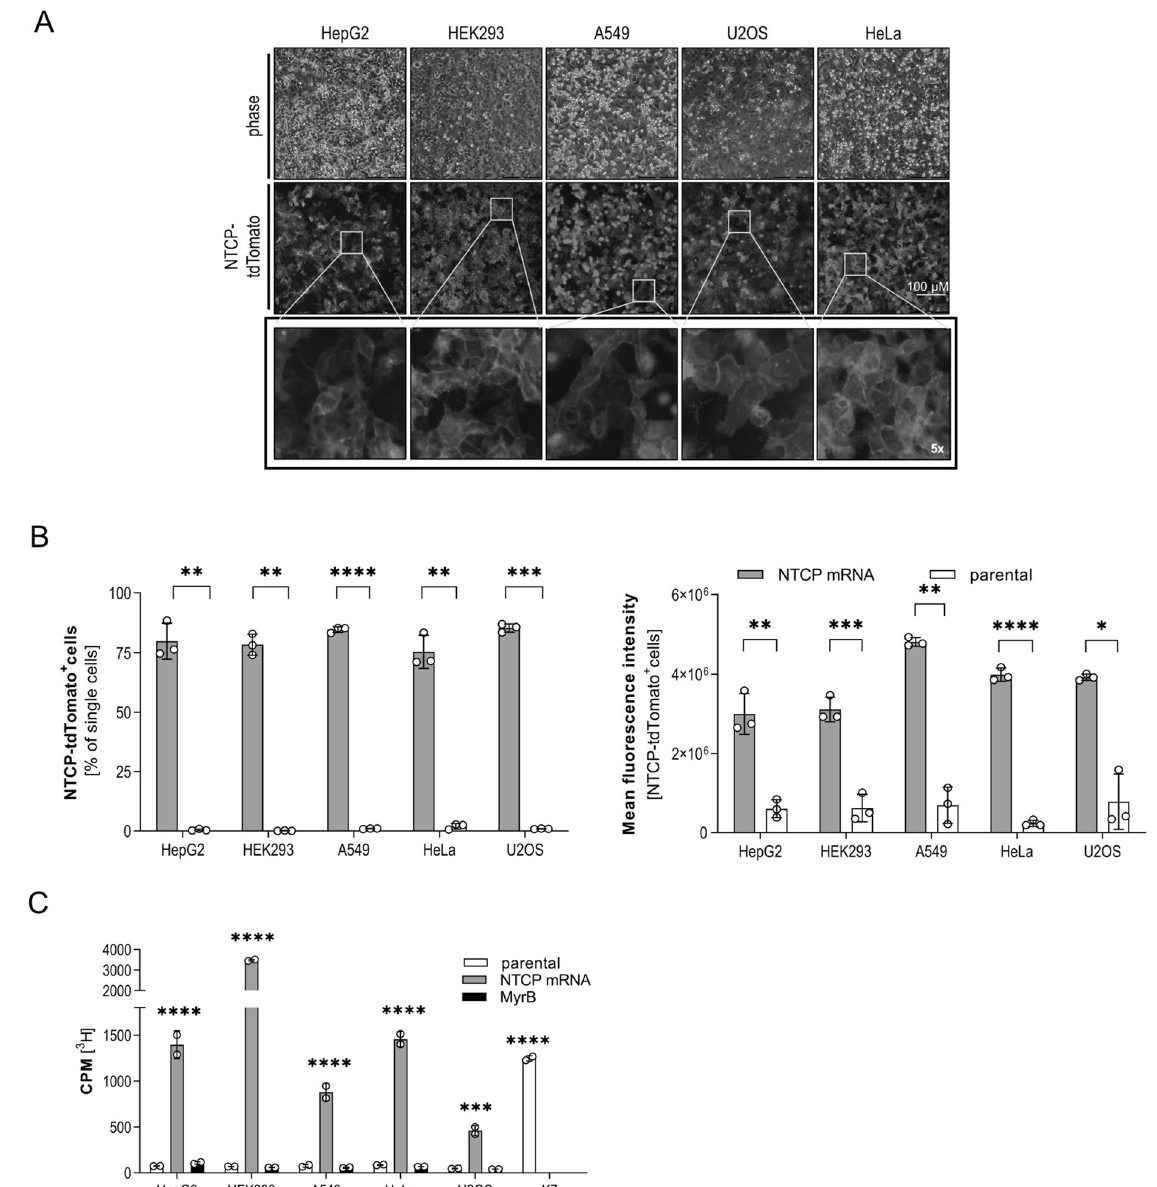
Figure 3. Expression of functional NTCP in non-hepatic cells. 500 ng IVT mRNA encoding NTCP-tdTomato was transfected into HepG2, HEK293, A549, HeLa and U2OS cells. ( A ) Phase contrast (phase) and fluorescence images of indicated cell lines 24 h post transfection (TXR-channel, 595 nm). Enlarged areas on the bottom show fivefold magnification. ( B ) After 24 h, tdTomato fluorescent cells were analyzed by flow cytometry in comparison to parental cells. Percentage of positive cells (left panel) and mean fluorescence intensity (right panels) is given. ( C ) Uptake of taurocholate [ 3 H] was determined 24 h post transfection of indicated IVT mRNA transfected cell lines. Parental cells and cells treated with 200 nM MyrB to block uptake served as negative control, HepG2-NTCP-K7 (K7) cells as positive control. Mean ± SD of three biological replicates is shown. Statistical significance was determined using Welsh corrected Student’s t test or one-way ANOVA. (*p < 0.05, **p < 0.01, ***p < 0.001, ****p <